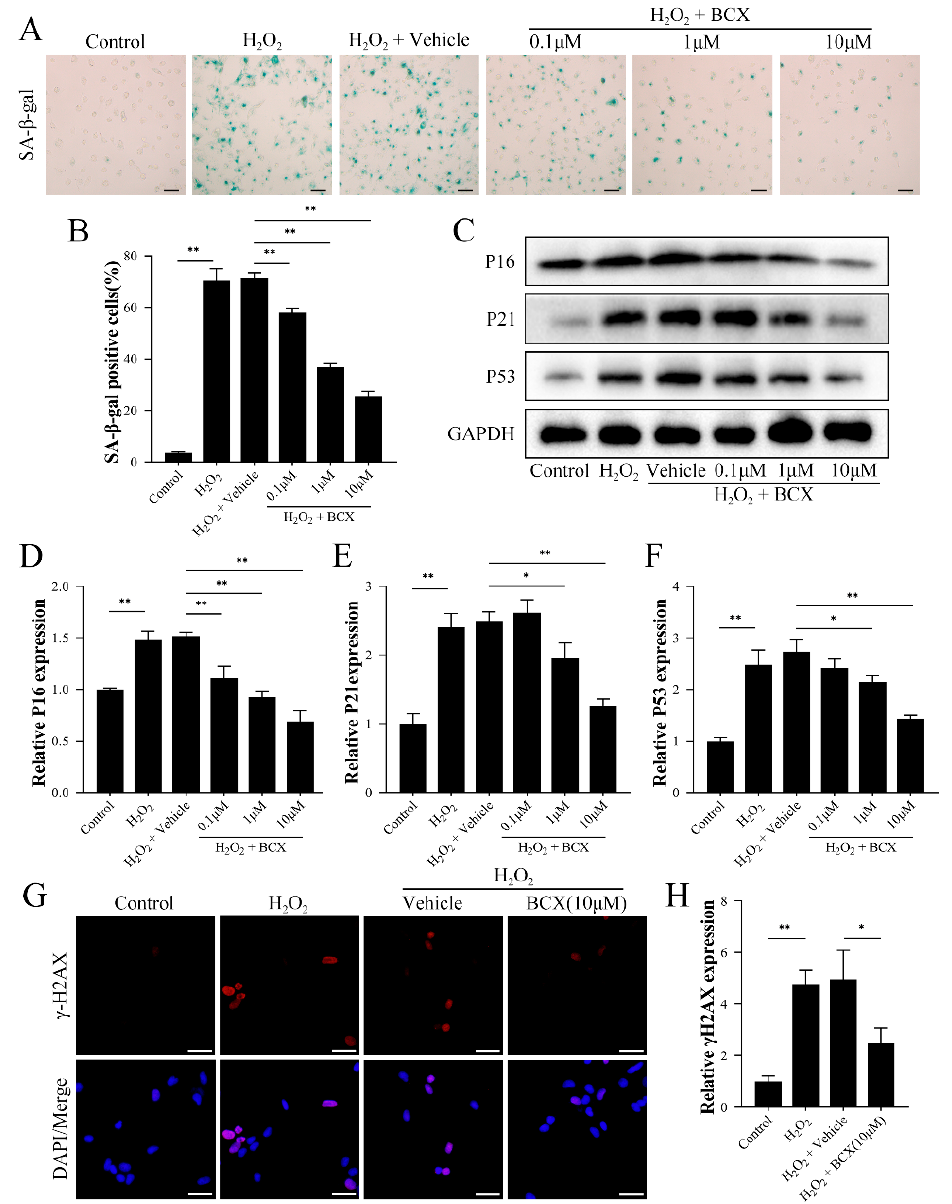
Figure 2. BCX inhibited oxidative stress-induced senescence in HK-2 cells in a concentration- dependent manner. After pretreatment with different doses of BCX (0.1, 1 and 10 µ M) for 24 h, HK-2 cells were treated with 800 µ M H 2 O 2 for 48 h. ( A , B ) Senescence levels of HK-2 cells were detected by SA- β -galactosidase staining. Scale bar = 50 µ m. ( C – F ) Western blot detection of expres- sion of senescence-associated proteins P16, P21, and P53. The quantitative analysis was expressed as a relative value to GAPDH. ( G , H ) Immunofluorescence detection of the expression of cellular senescence marker γ -H2AX. Scale bar = 40 µ m. Values are expressed as mean ± SD. The mean value is the average of the results of three replicate experiments. n = 3. * p < 0.05 and ** p <